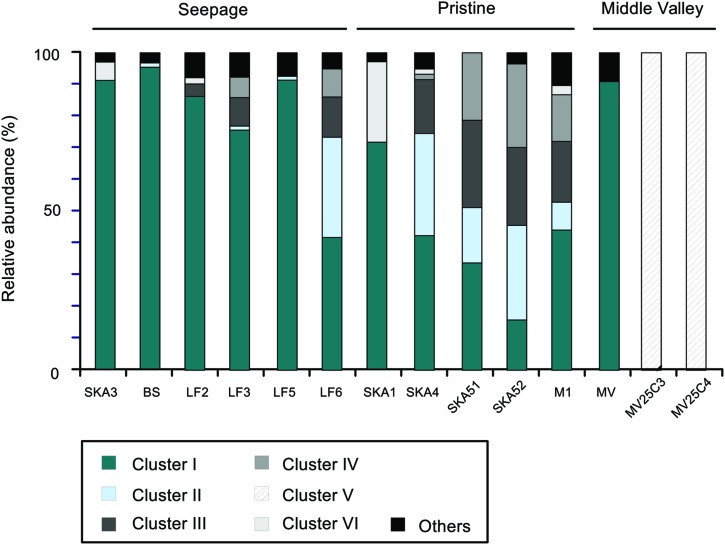
Relative abundance of the six most abundant masD/assA gene sequence clusters. Clusters I–VI were defined as sharing 75% amino acid sequence identity (see Figure 1).